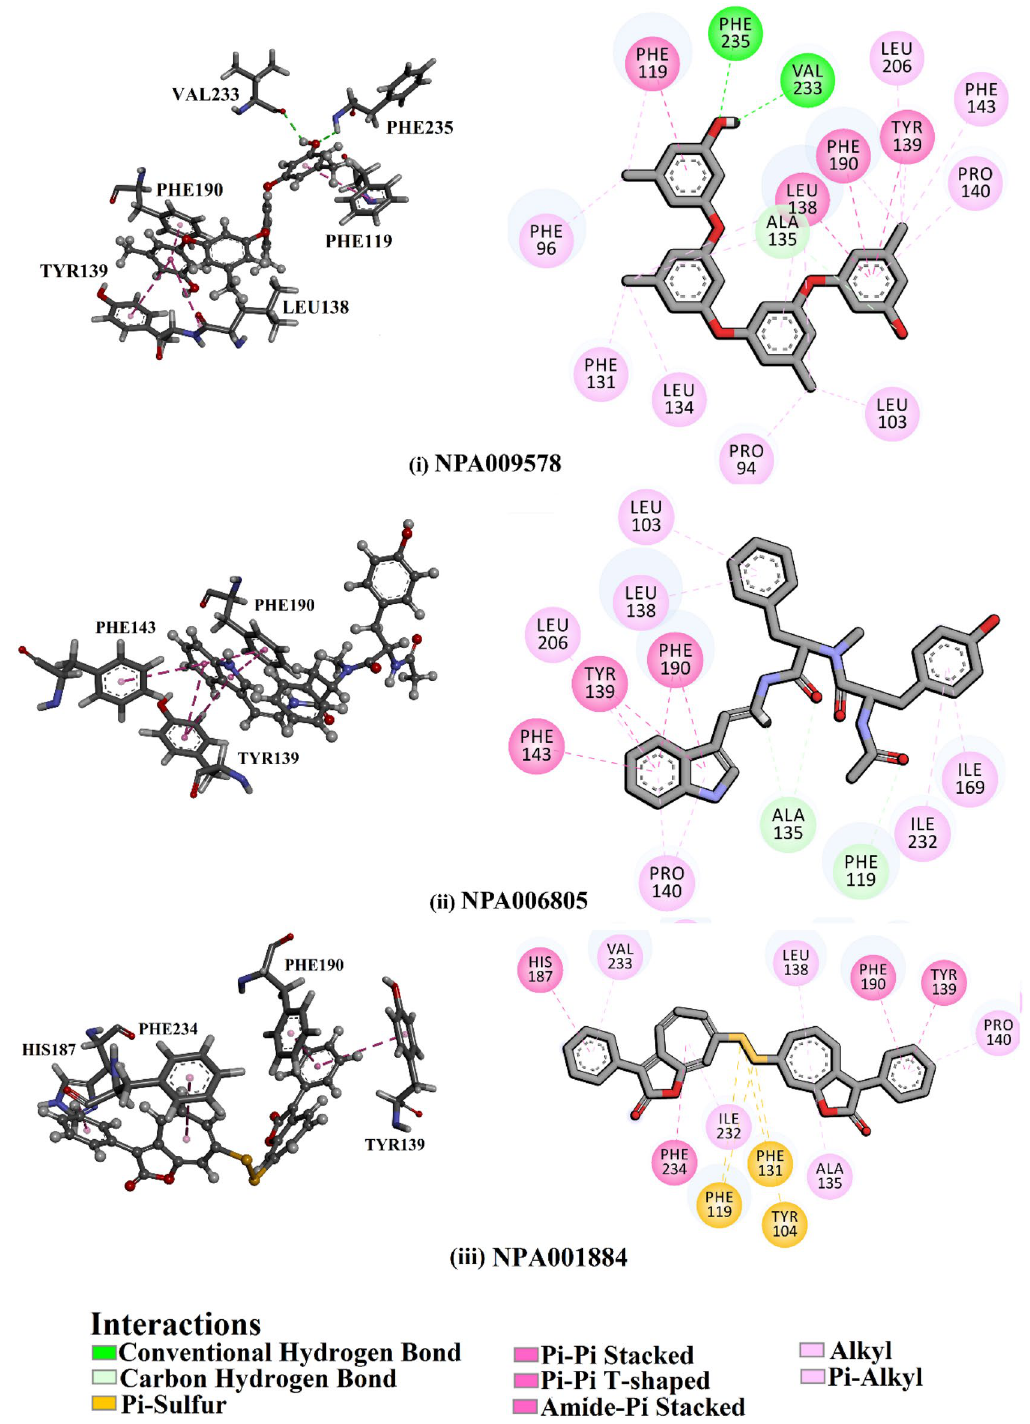
Figure 4. Three- and two-dimensional representations of the anticipated docking poses of (i) NPA009578, (ii) NPA006805, and (iii) NPA001884 against SIRT2 protein, utilizing expensive docking